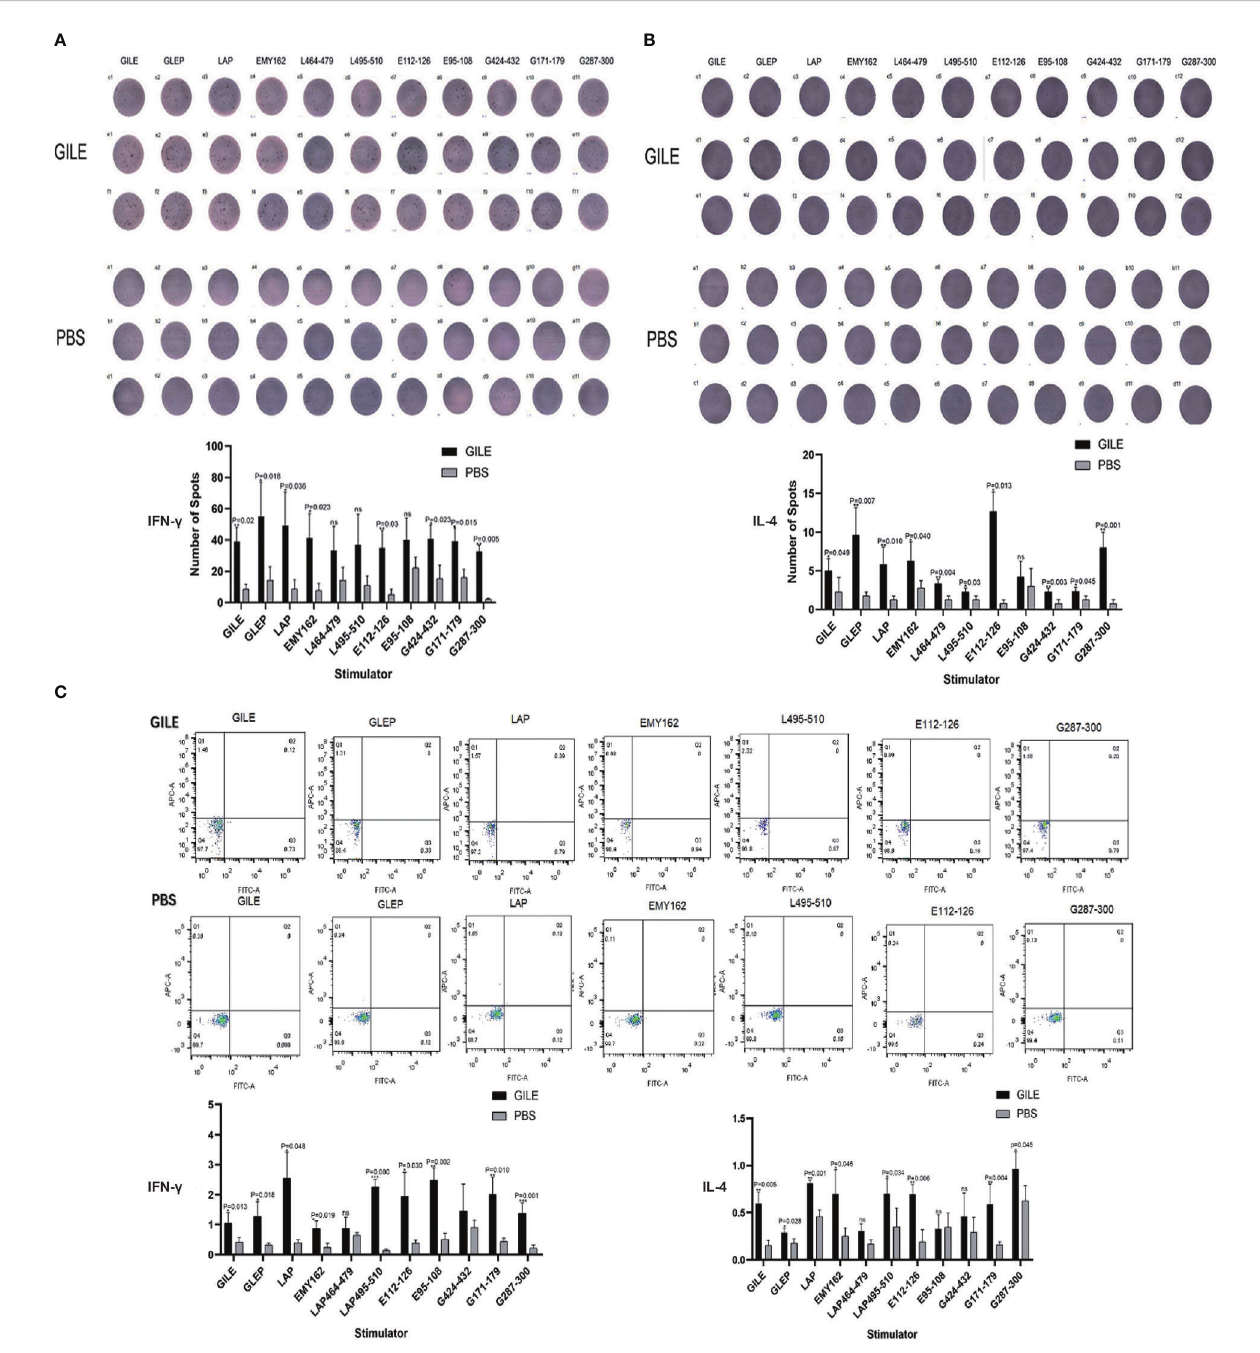
FIGURE 5 Detection of every group ’ s spleen cytokine by Elisapot and FCM. (A) : Detection of mice spleen IFN- g level and counting every well plates spots number; (B) : Detection of mice spleen IL-4 level and counting every well plates spots number; (C) : Detection of cytokines IL-4 and IFN- g level by FCM. ns means no statistical signi fi